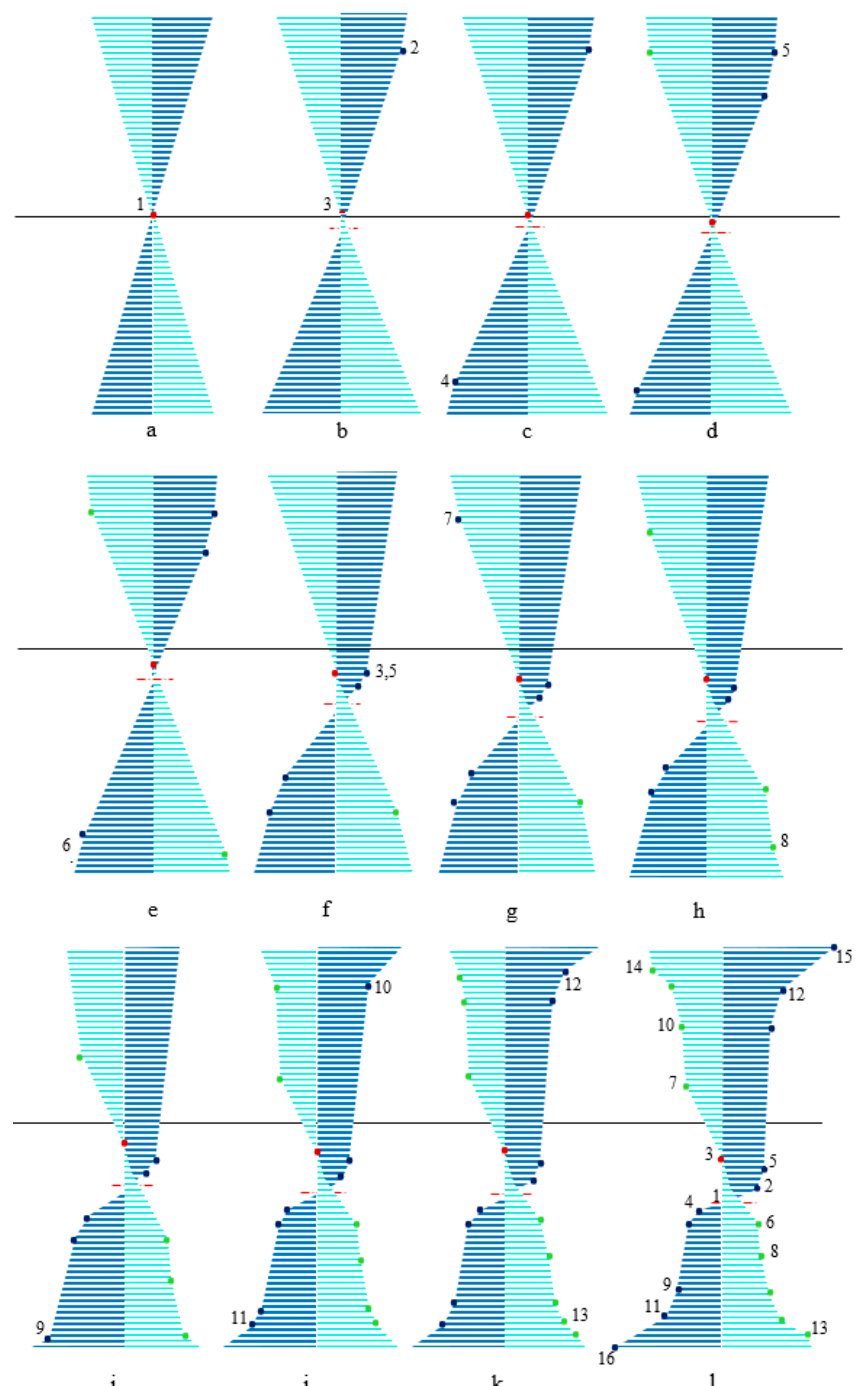
Figure 5. Schematic of stress–height variations for an SMA beam at low temperature during unloading in ( a ) elastic zone, ( b ) T1-zone favored by tension, ( c ) T1-zone favored by compression, ( d ) VR-zone favored by tension, ( e ) VR-zone favored by compression, ( f ) when S z with d u , ( g ) due to reverse T-zone, ( h ) due to reverse VR-zone, ( i ) T2-zone favored by compression, ( j ) T2-zone favored by tension, ( k ) D-zone favored by compression, ( l ) D-zone favored by tension. Figure 5 indicates the most general case where all unloading states can simultane- ously occur. To set out in detail, Figure 6 clarifies how unloading process can act as below: Elastic unloading for paths 3–7 and 14–15 in tension, as well as 1–4, 4–6, 6–8, and 13– 16 in compression.